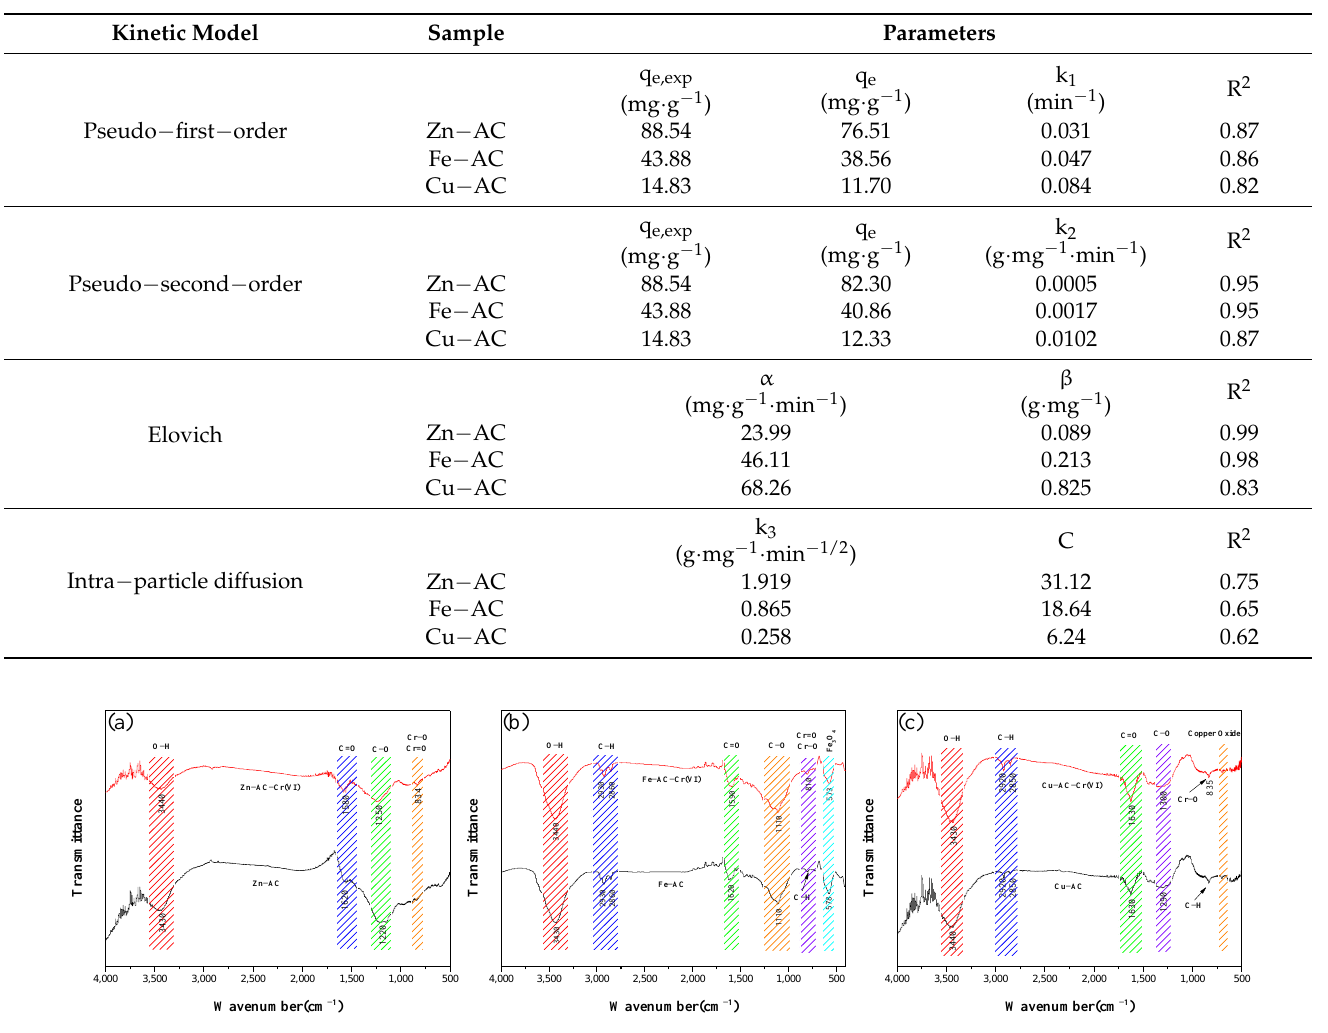
Table 4. Parameters of the kinetic models for Cr(VI) adsorption onto activated carbon derived from WPTs.